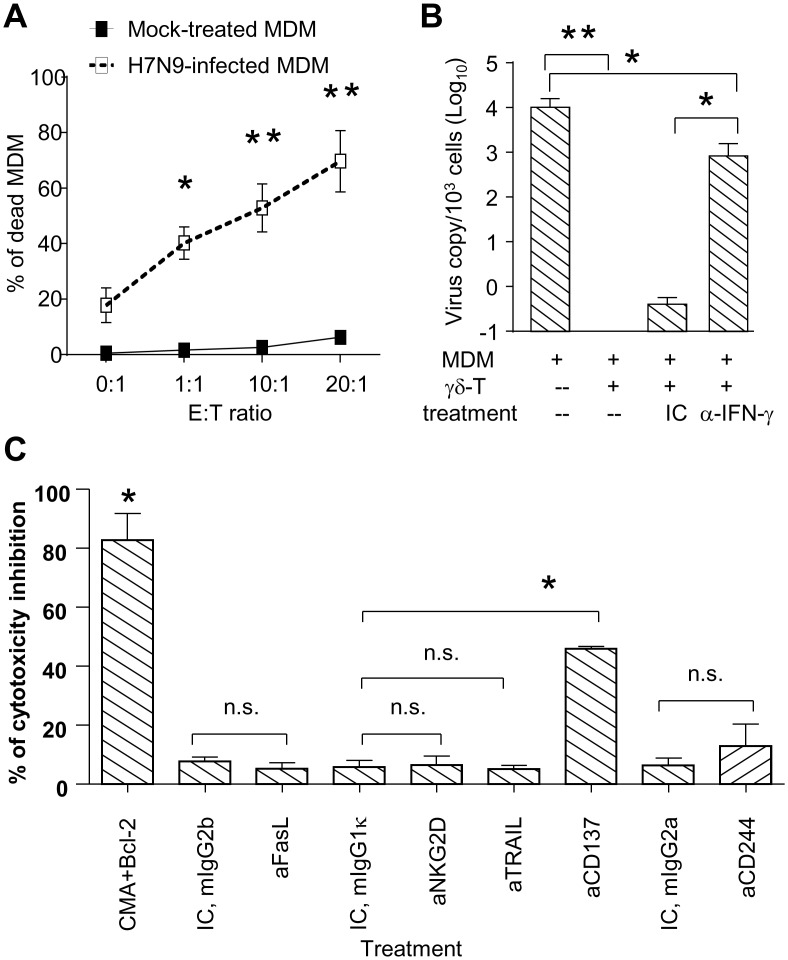
Pamidronate-expanded Vδ2-T cells exhibited both non-cytolytic and cytotoxic antiviral activities against H7N9 virus infection.Human MDMs (target, T) were infected with H7N9 virus or mock at MOI of 2 for 1 hour, and then co-cultured with pamidronate-expanded autologous Vδ2-T cells (effector, E) at indicated E:T ratios for 6 hours. The cytotoxicity of Vδ2-T cells was determined by EthD2 staining on dead MDM at the final 15 minutes of co-culture (A). To determine whether IFN-γ released from Vδ2-T cells was involved in the inhibition of viral replication, Vδ2-T cells and virus-infected MDMs were co-cultured at 1:1 of E:T ratio for 48 hours in the presence of IFN-γ neutralizing antibody (10μg/ml) and its isotype control (IC, goat IgG) respectively. The virus copies (B) in the co-culture were then determined by qPCR (n = 4). (C) Pamidronate-expanded Vδ2-T cells were co-cultured with virus-infected MDMs at a E:T ratio of 10: 1 for 6 h. The perforin inhibitor CMA and granzyme B inhibitor Bcl-2 (both at 1μg/ml), anti-NKG2D (aNKG2D), anti-TRAIL (aTRAIL), anti-FasL (aFasL), anti-CD137 (aCD137), anti-CD244 (aCD244) blocking antibodies (all at 10μg/ml), or their relevant isotype controls were added into the culture since the initiation of incubation. The death of virus-infected MDMs was analyzed by flow cytometry. *p<0.05; **p<0.01; n.s., no significance.